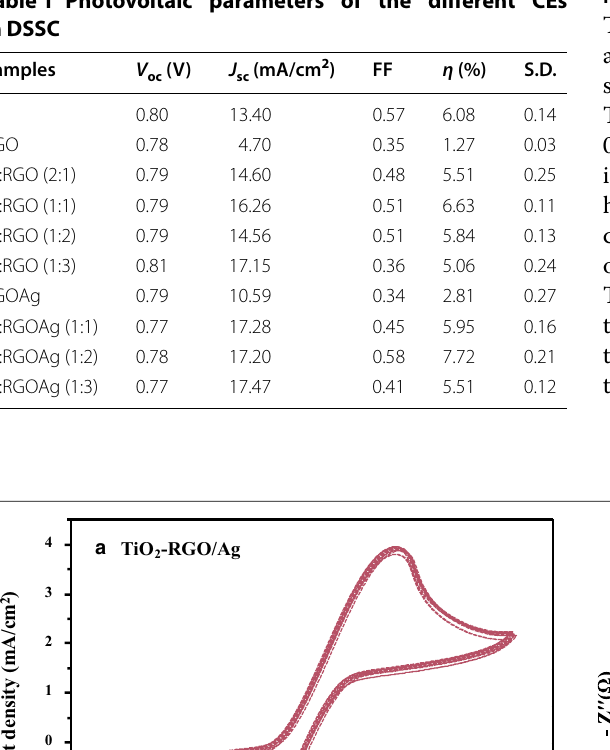
Table 1 Photovoltaic parameters of the different CEs in DSSC